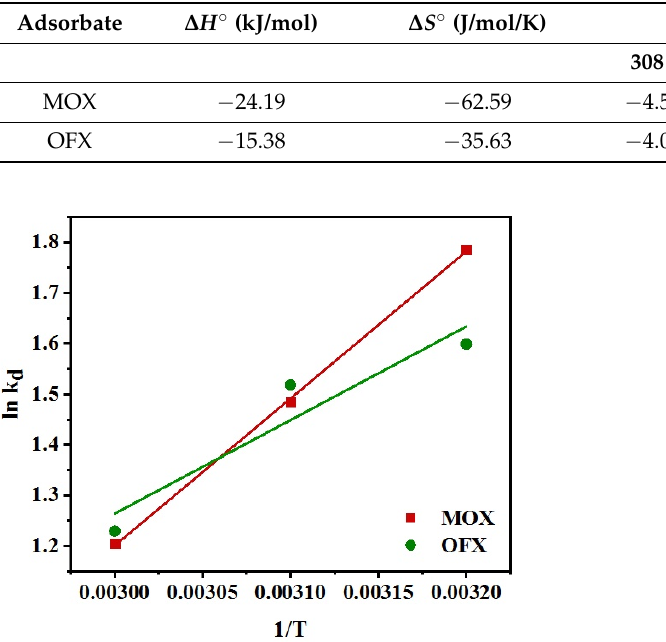
Figure 14. Van’t Hoff plots for the uptake of MOX and OFX on the Met-GO/SA (Adsorption